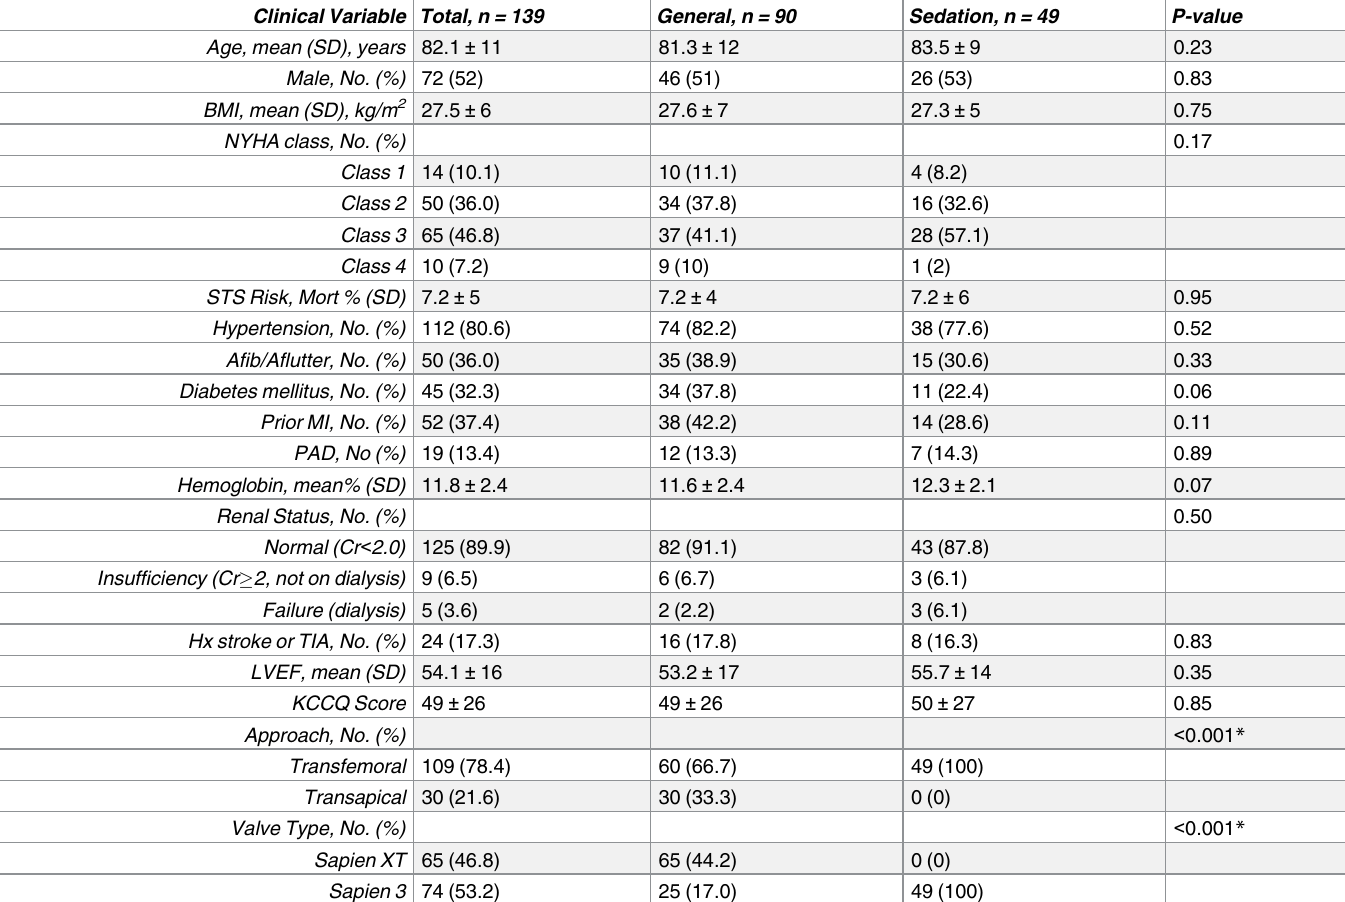
Table 4. Patient characteristics; excluding Sapien 1